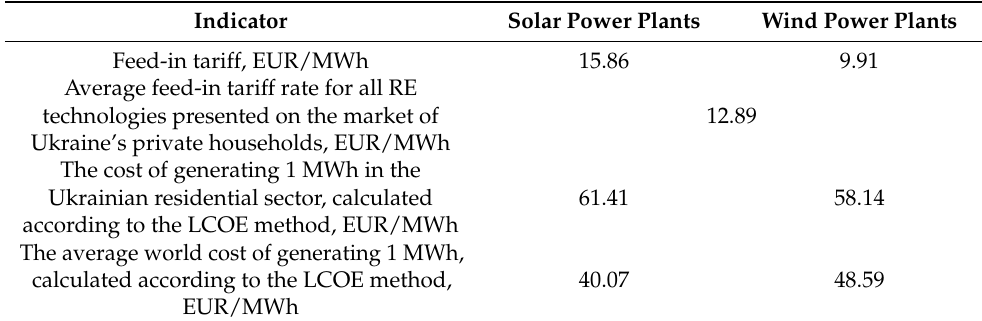
Table 4. Feed-in tariff and cost (according to the LCOE method) of electricity generated by household 30-kW solar and wind power plants (calculated by the